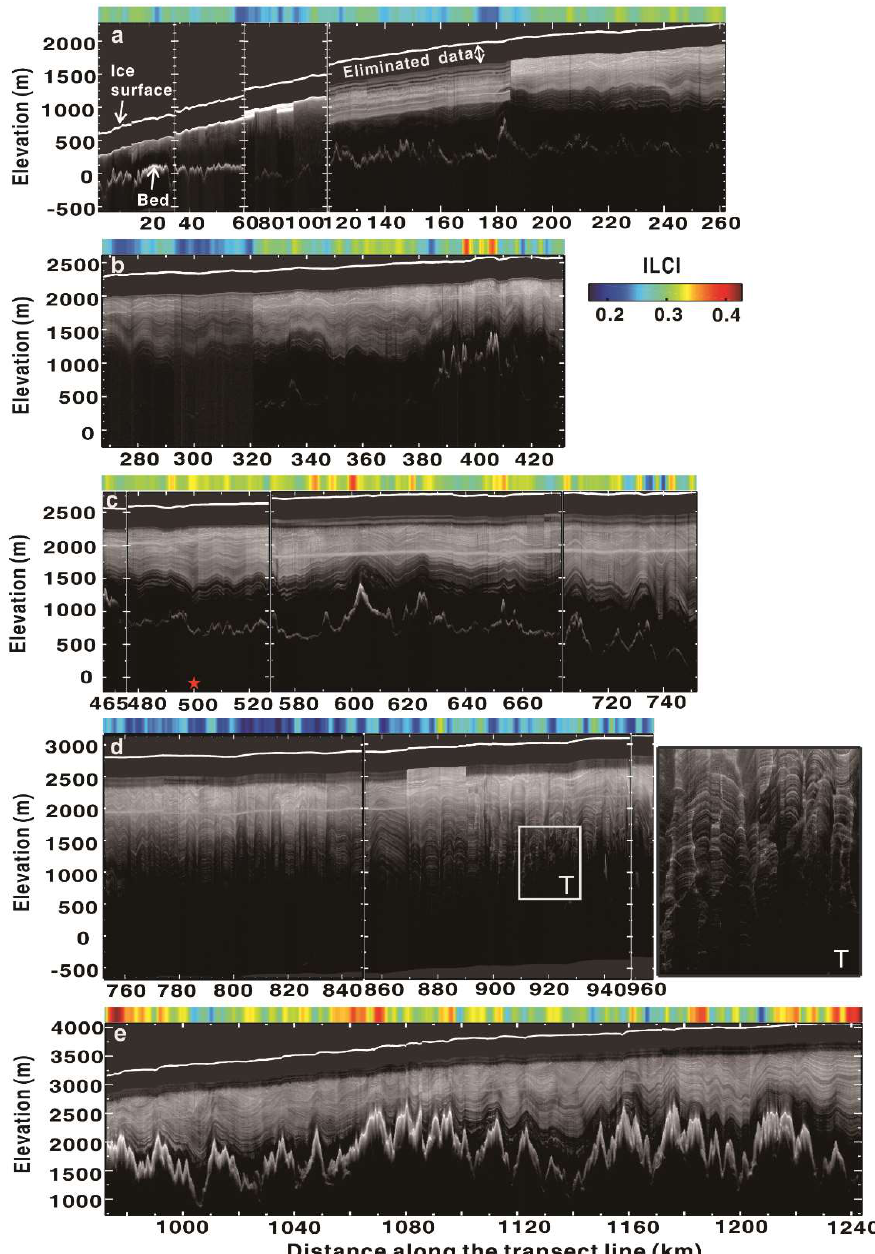
Figure 3. Radar profiles and Internal Layering Continuity Index (ILCI) diagram of the traverse from Zhongshan to Dome A. ( a – e ) represent the regions of Zone A, Zone B, Zone C, Zone D, and Zone E, respectively. ILCI is the result of the average from the 500-trace window. The red star marks the location of Taishan Station. The profile in T is the position of the white rectangle in Figure 3d. The white line in the radar profile indicates the surface, and the ice thickness of about 340 m (2000 sampling points) in the middle is the eliminated data.